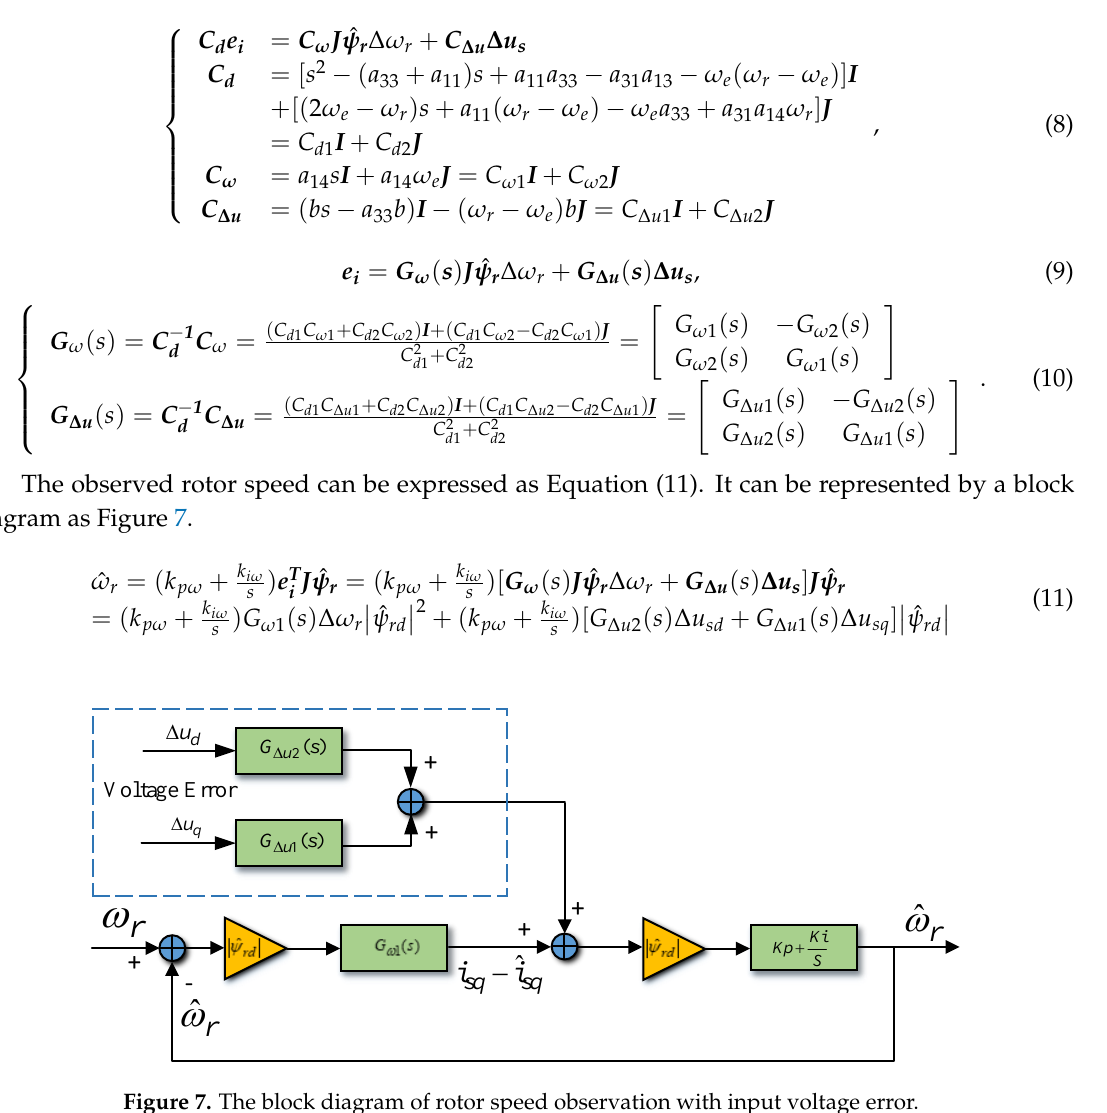
Figure 7. The block diagram of rotor speed observation with input voltage error.